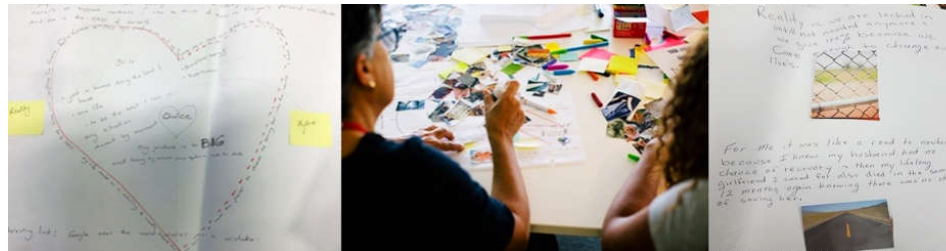
Figure 1. Image maps, using visual symbols to describe reality and myths of being a